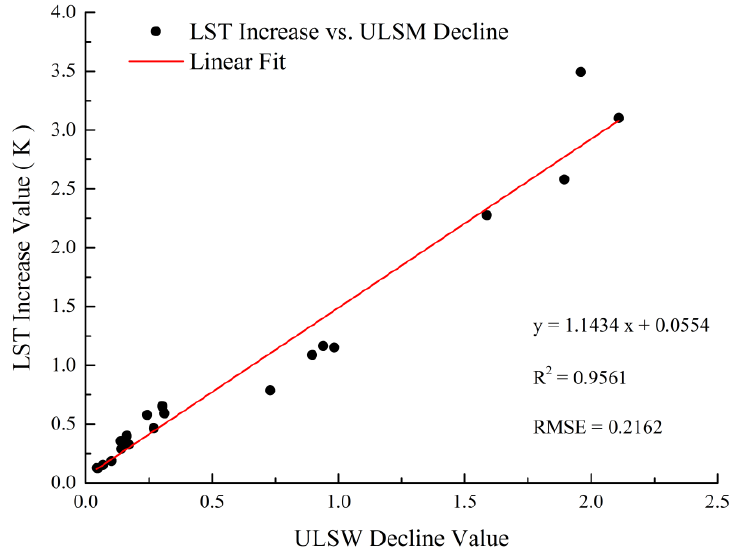
Figure 8. Fitting curve of the LST increasing value vs. the ULSM declining